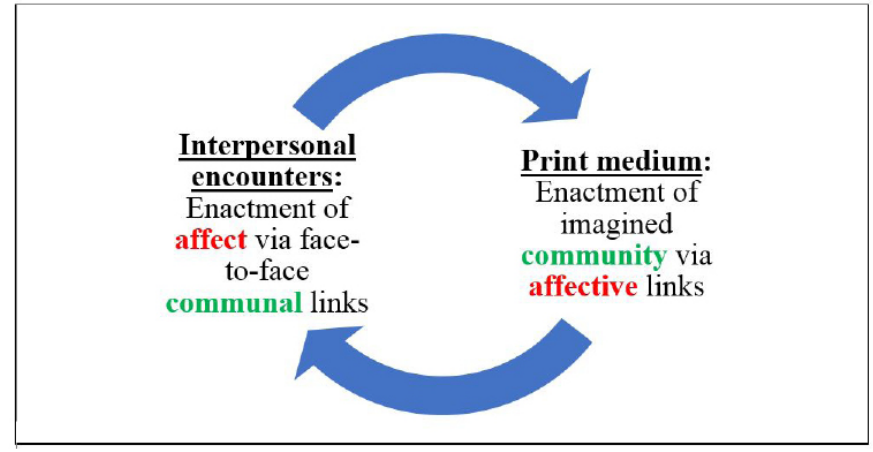
Fig. 2 Cycle of affect and